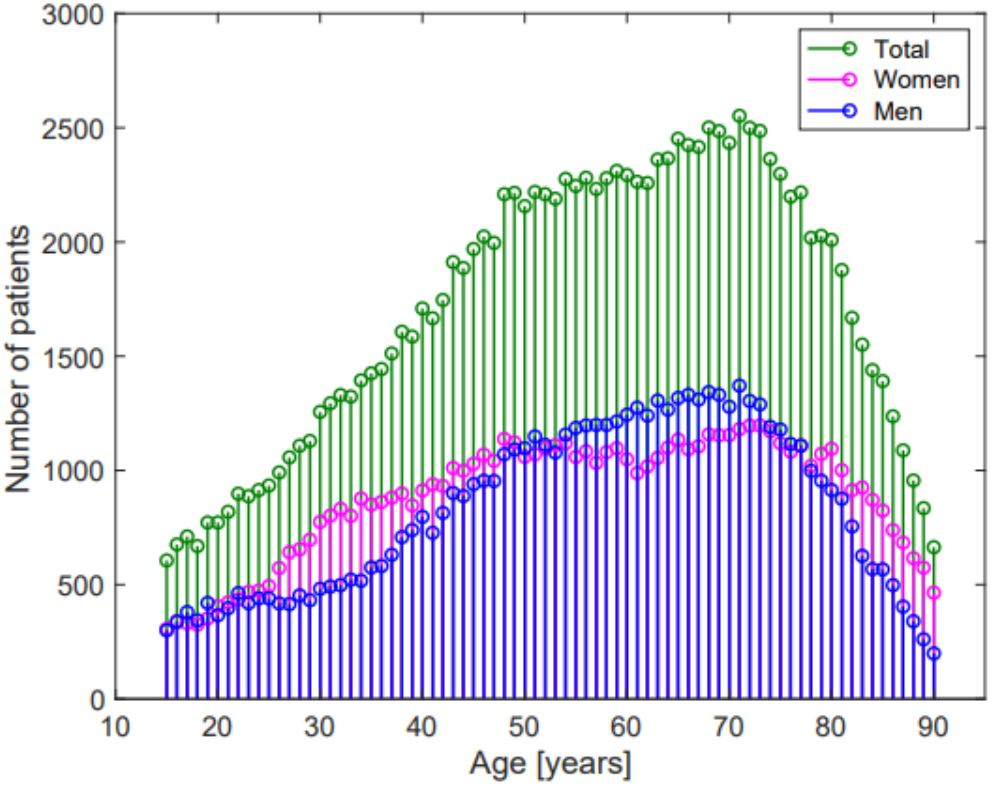
Figure 1. Age-distribution of the study population. Table 2. Mean ECG values and Z-scores −2 and +2 in the study population and in the three groups.